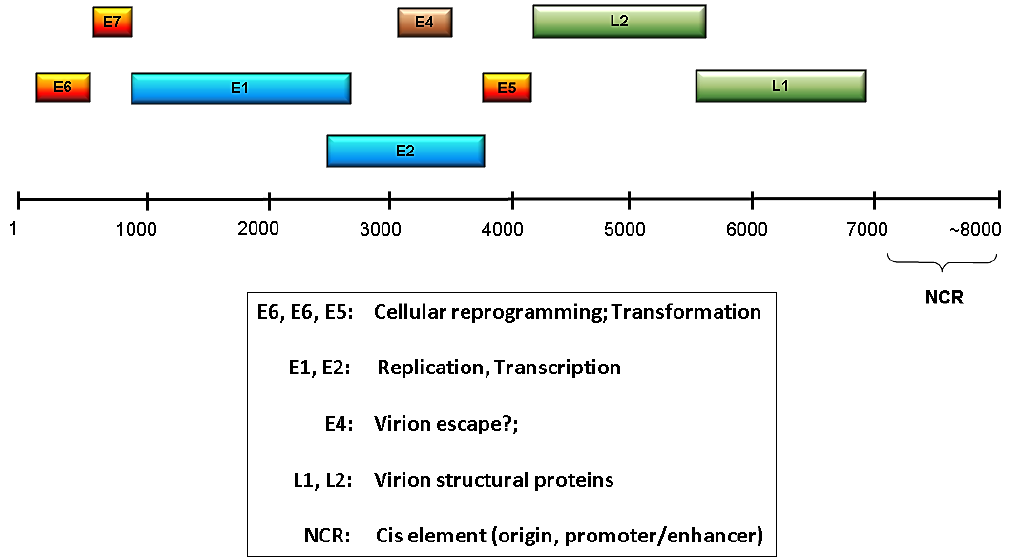
Figure 1. HPV genome organization and function. Shown is a linearized HPV genome with the relative genomic locations of the early (E) and late (L) ORFs indicated. The NCR is the noncoding region that contains the viral replication origin and transcriptional regulatory elements. Functions associated with the various ORFs are listed in the box below the